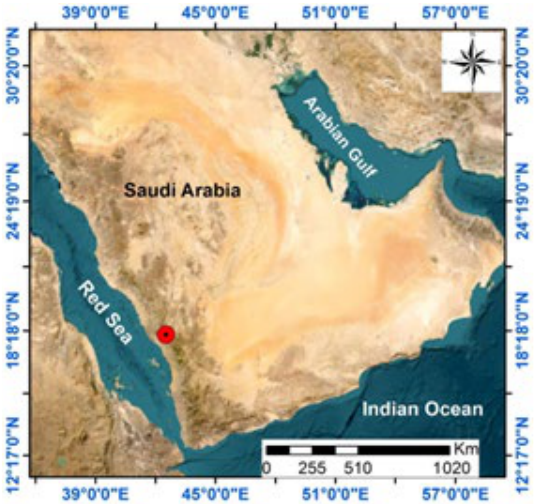
Figure 3. Map showing the location of Wadi Qaradah in Southwest Saudi Arabia, indicated with the red pinpoint.